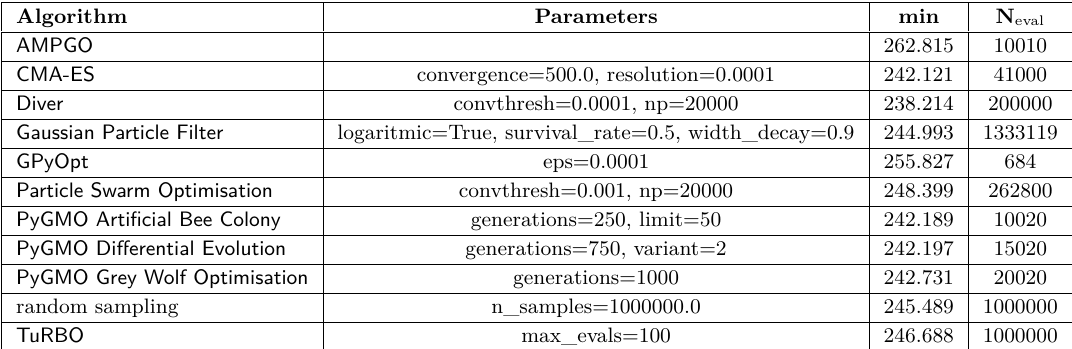
Table 7. Best obtained result for the approximation of the 12-dimensional MSSM7 log-likelihood described in section 3.2. The ‘best’ result is the result with the lowest found function value. If multiple samples found the same value, the result with the fewest number of needed function evaluations is